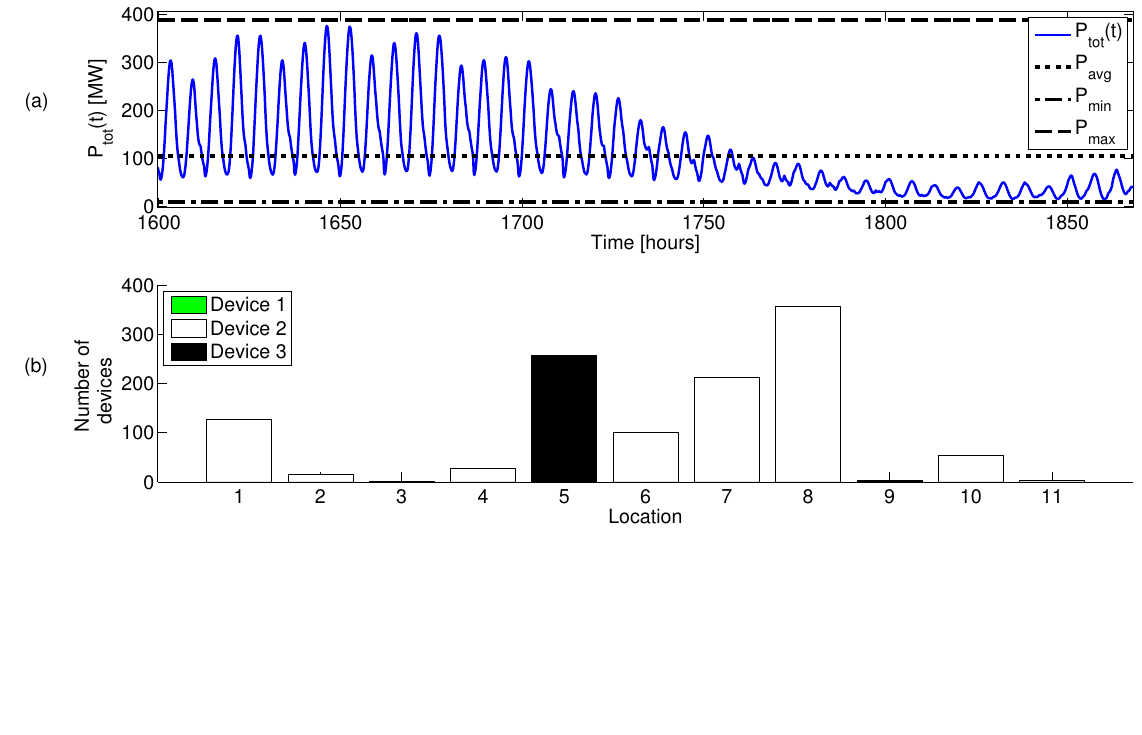
Figure 7. Simulation results for Solution 1 (solution with the highest average power and the highest minimum power). ( a ) Zoom of the total power P tot ( t ) ; ( b ) Number of installed devices at each